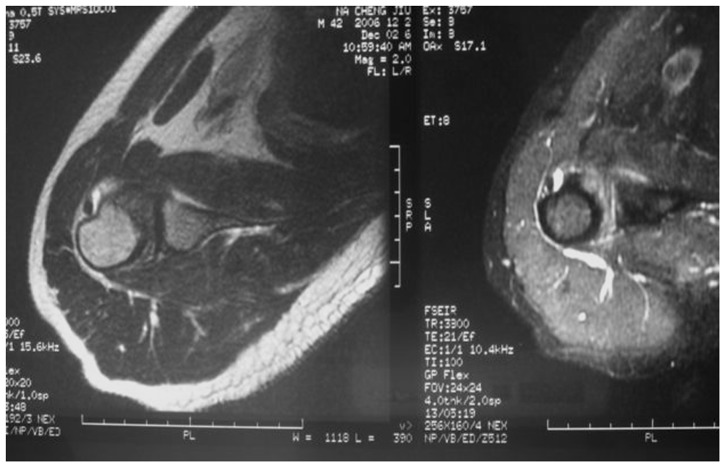
Synovitis-like abnormalities around the long biceps tendon in a 57-year-old patient of with AC.T2 prolongation (hyperintensitiy) was observed around the tendon (low signal structure).